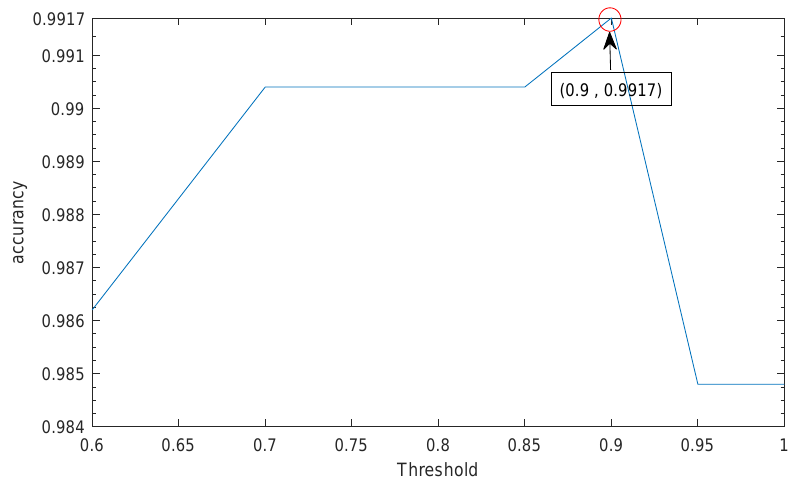
Figure 8. The accuracy of the data corresponding to the threshold. Table 4. The corresponding threshold